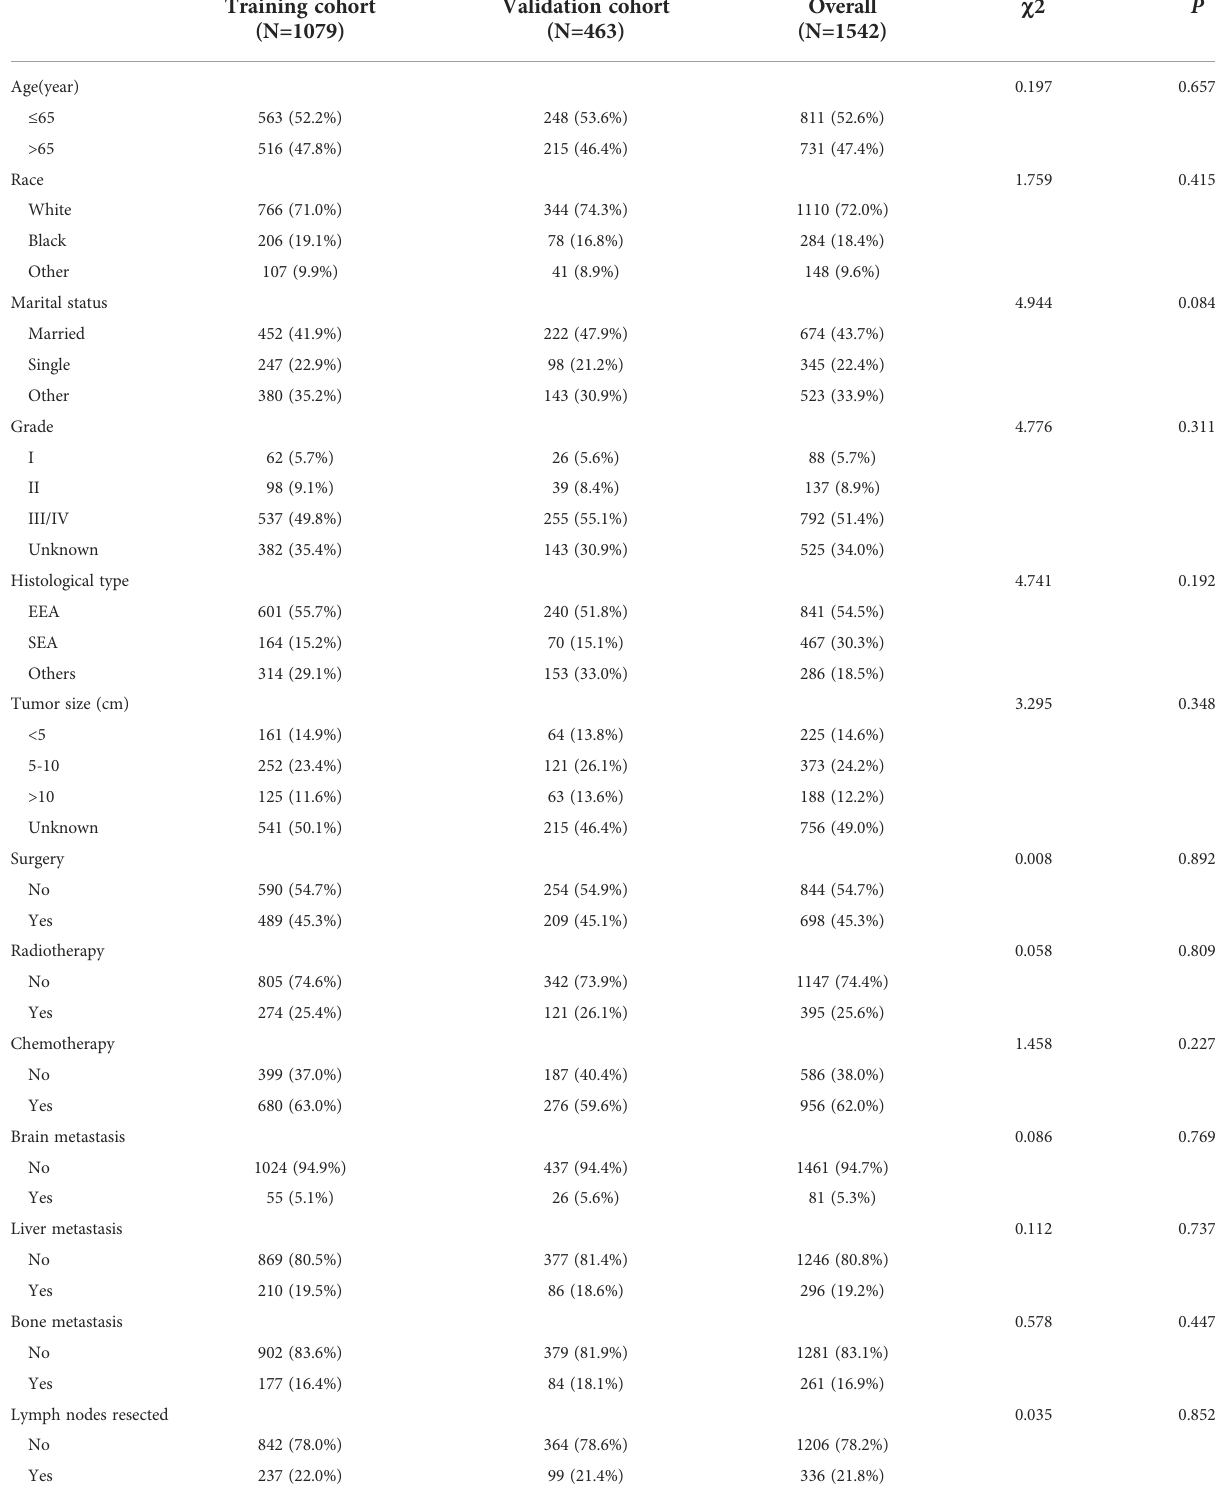
TABLE 1 Demographic and clinical characteristics of EC patients with lung